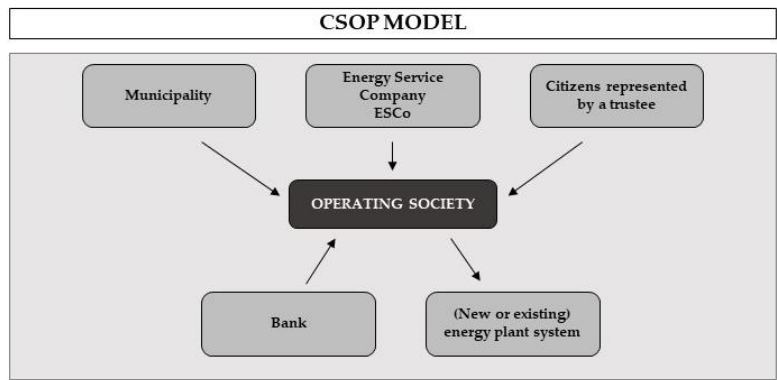
Figure 3. Financing of a renewable energy (RE) plant and energy efficiency (EE) measures through a CSOP, authors’ elaboration.